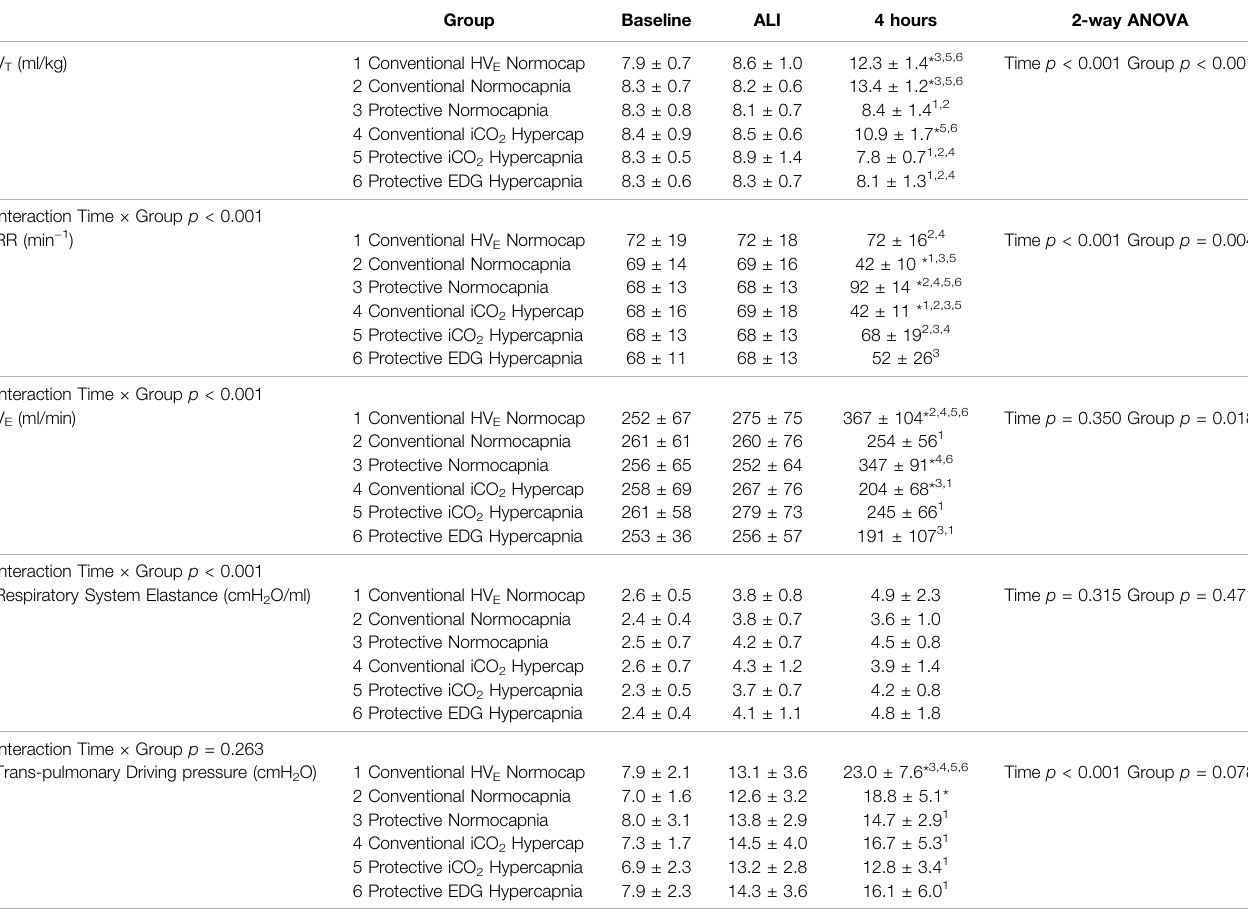
TABLE3| Respiratorymeasurementsatbaseline,ALIand4 hofventilationineachgroup,includingtidalvolume(V T ,ml/kg),respiratoryrate(RR,breathsperminute,min − 1 ), minute ventilation (V E , ml/min), respiratory system elastance (cmH 2 O/L) and transpulmonary driving pressure (cmH 2 O). Values are expressed as mean ± SD. Baseline datagivenforreferenceonly,but notincluded intostatistical analysis.*denotes signi fi cantdifference vsALImeasurements; numbersdenote signi fi cantdifferences between